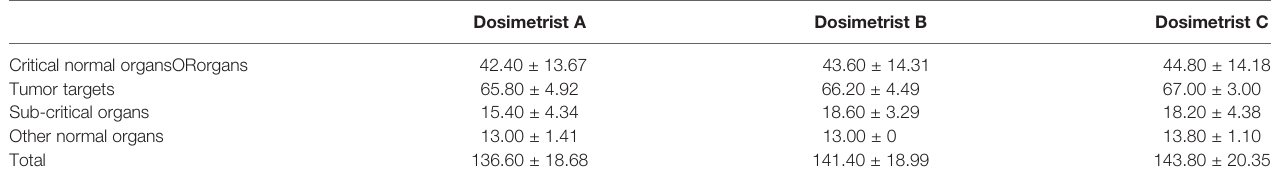
TABLE 6 | Plan quality metric scores for three different dosimetrists of varied skill levels, namely A, B, and C.